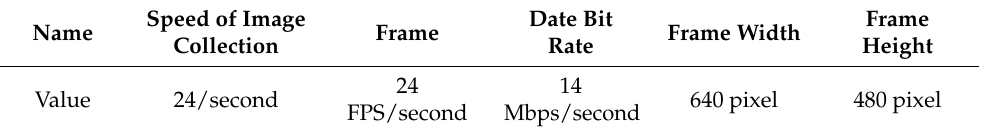
Table 2. Performance from the PERCLOS detection.